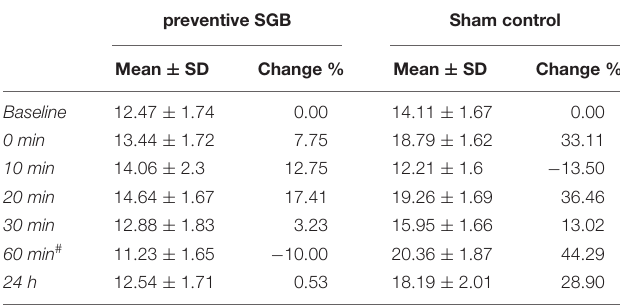
TABLE 3 | cfDNA levels within the first 24 h following the induction of DOMS. preventive SGB Sham control